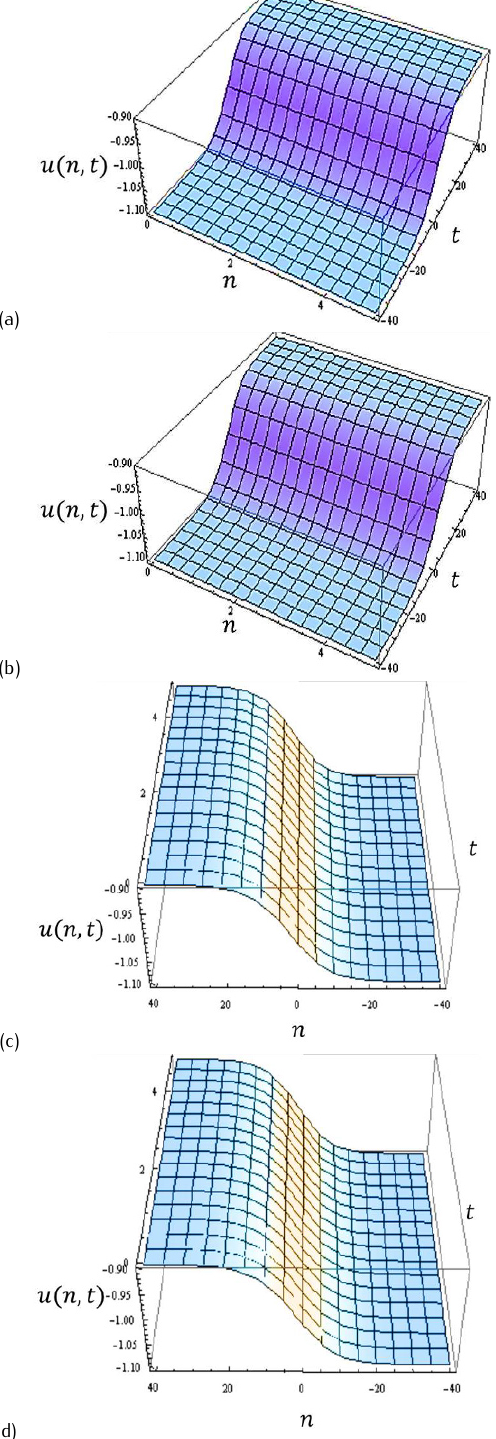
Figure 5. Explicit numerical solutions of Eq. (16) for u